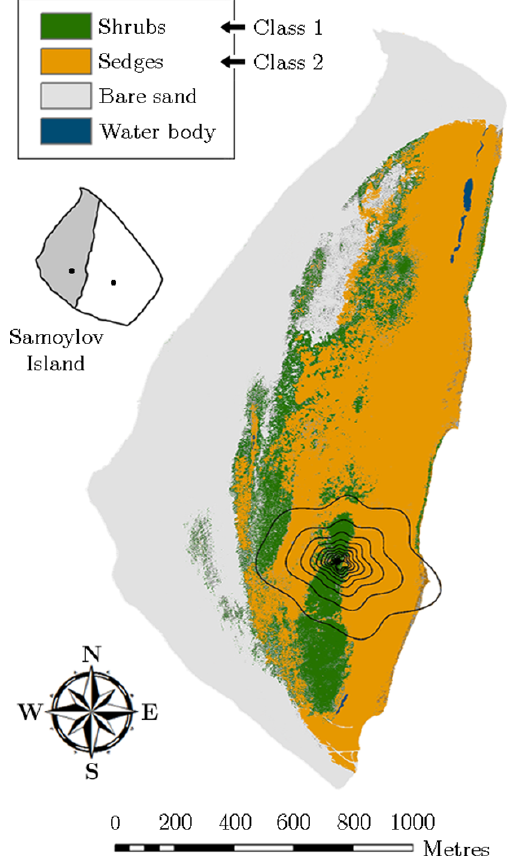
Figure 2. Vegetation map of the flood plain on Samoylov Island obtained through supervised classification of a high-resolution or- thomosaic. The flux tower was situated in the centre of the footprint isolines, which indicate the averaged area from which 10%–90% (increments of 10%) of the flux originated during the measurement periods of 2014 and 2015 (footprint climatology). The small inset illustrates Samoylov Island being composed of flood plain (grey) and river terrace (white) plus the location of their respective flux